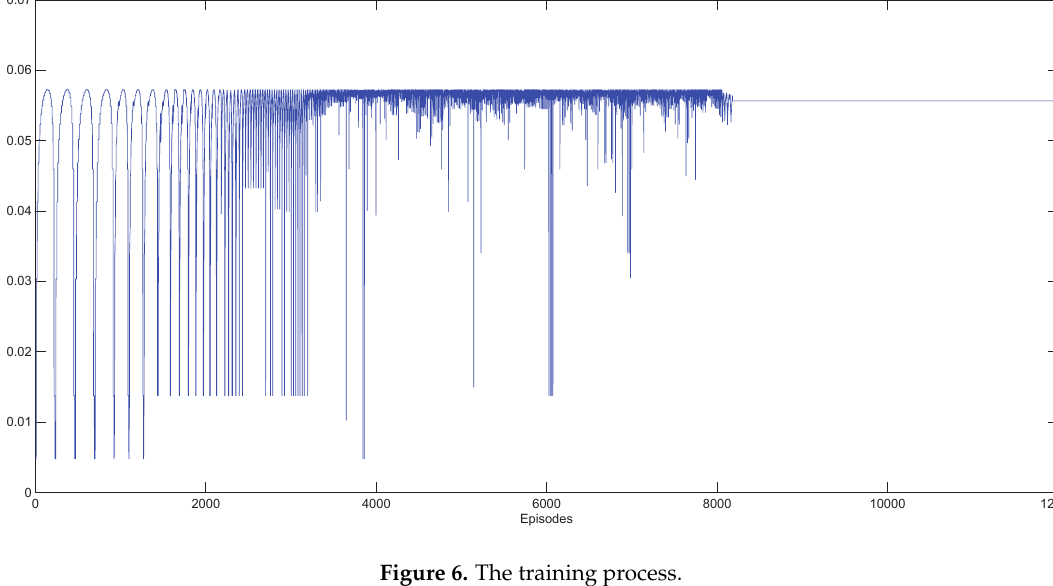
Figure 6. The training